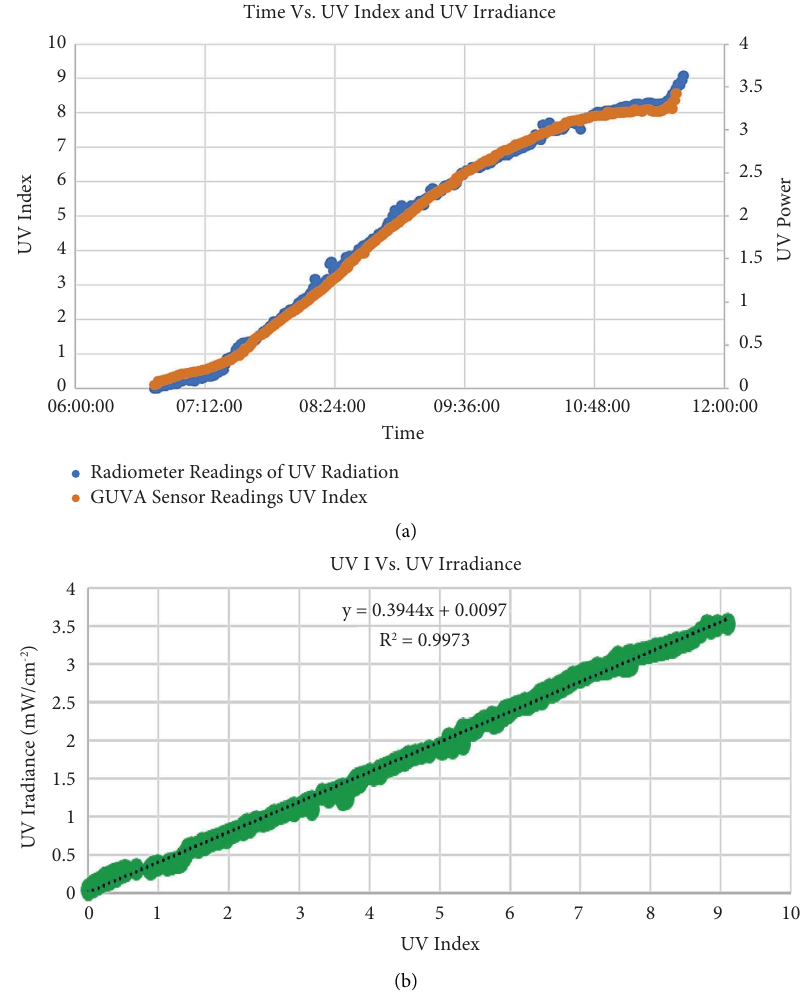
Figure 8: (a) Te relationship between time, UV irradiance (blue), and UV index (orange) (b) Te linear curve between UVI and UV